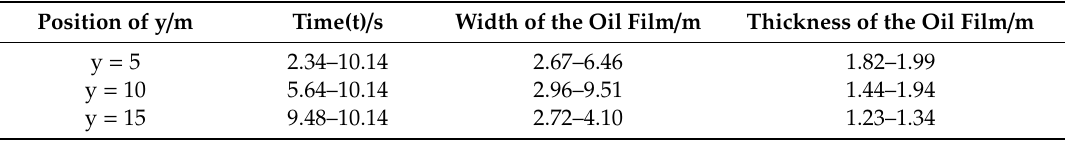
Table 2. Numerical results of drift and diffusion of oil film.